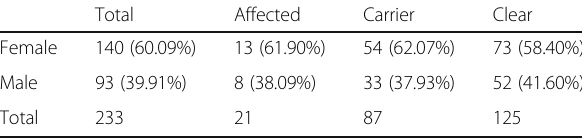
Table 1 Sex distribution of PBGV, with comparison between genotypes